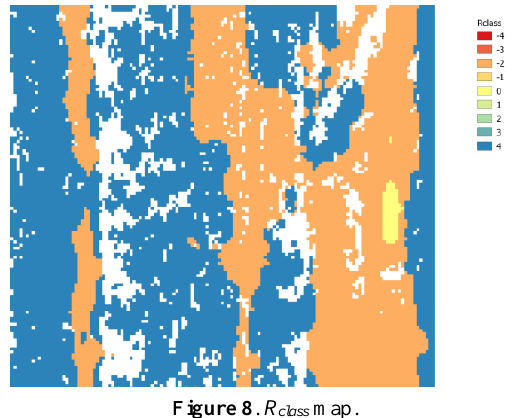
Figure 8 . R class